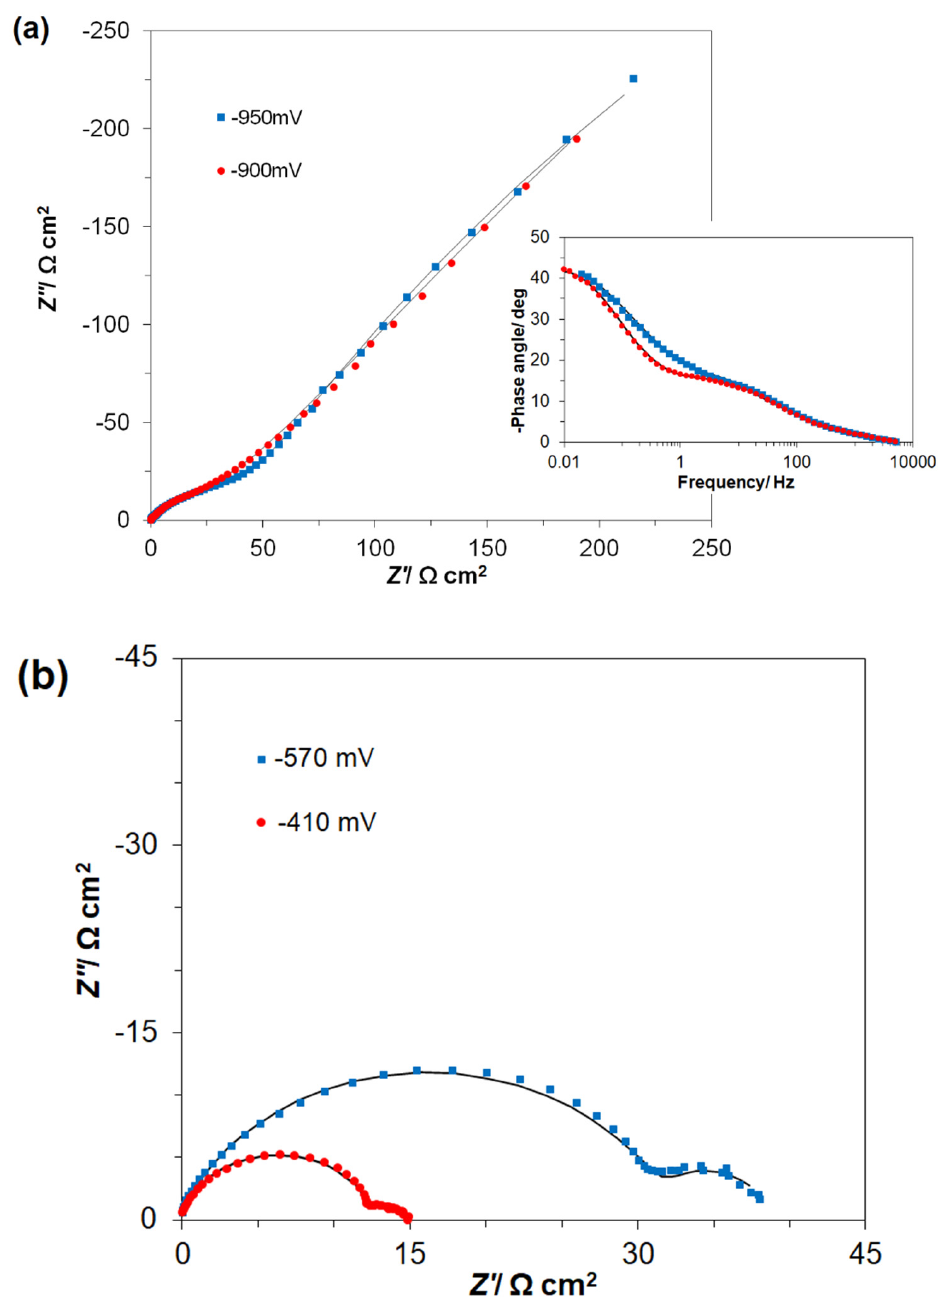
Figure 4. The recorded complex plane Nyquist impedance plots for low carbon steel electrode in contact with AM-modified (50 mg dm − 3 ) Na 2 SO 4 solution, derived for the stated potential values vs. SCE, where ( a ) corresponds to the surface formation of iron II hydroxide layer and ( b ) corresponds to iron oxidation to form Fe 3 O 4 or Fe(OH) 3 species along with consecutive surface electrooxidation of the dye. The solid lines correspond to the representation of the data according to the equivalent circuit model presented in Figure 5.